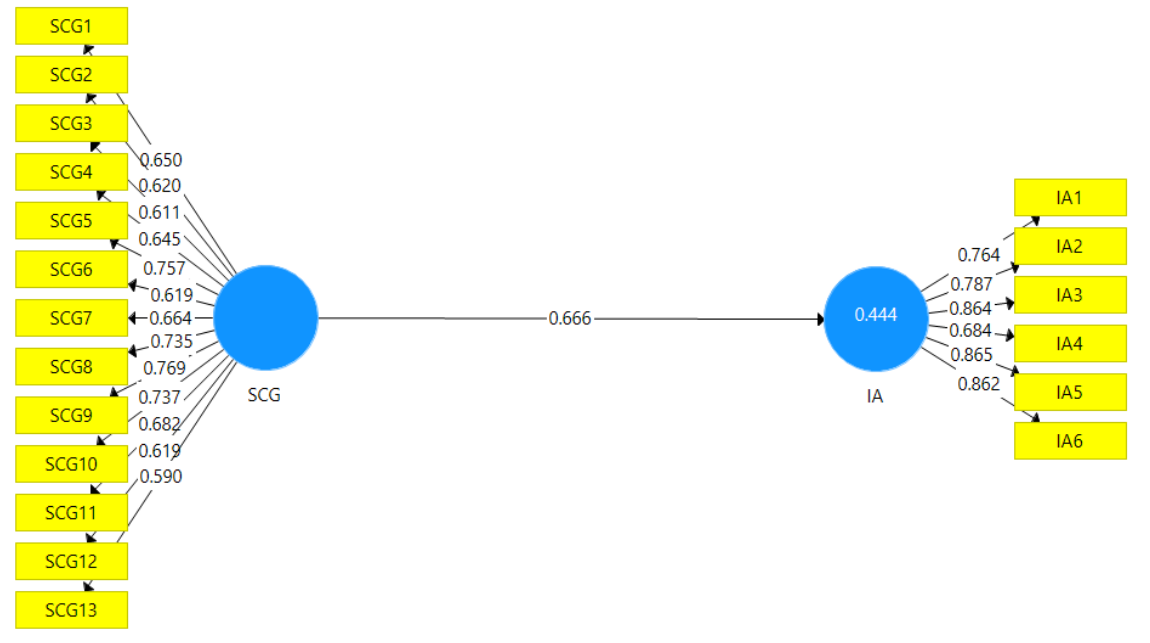
Figure 1. Value of Outer-loading and R 2 .